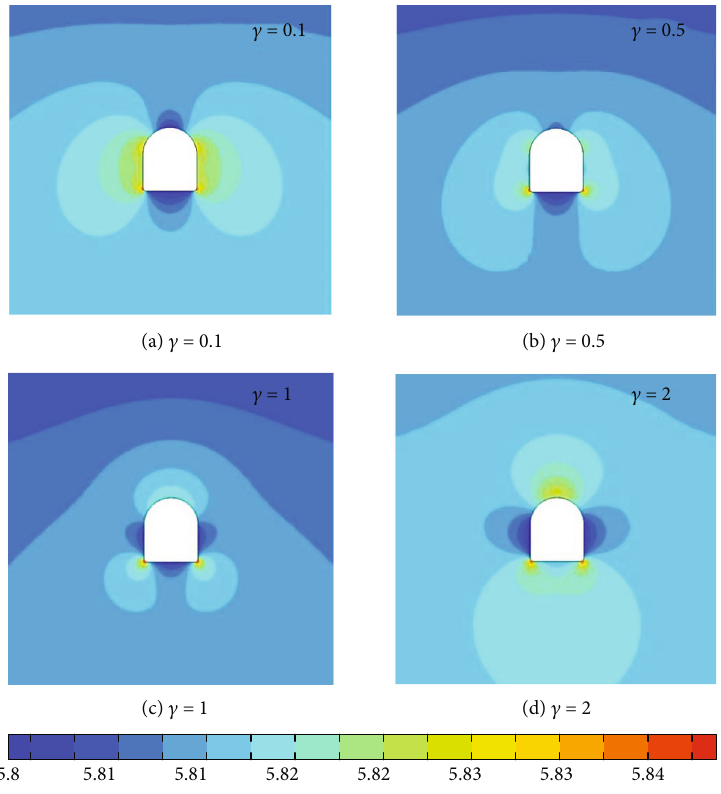
Figure 12: The permeability distribution of rock mass of karst tunnel.